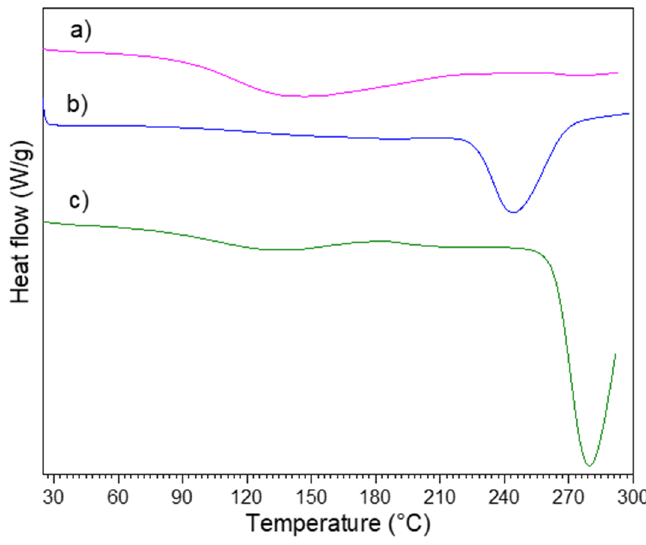
Figure 4. DSC curves of (a) HT-CCuNP10.0, (b) HT-CCuNP5.0 and (c) HT-CCuNP2.5.